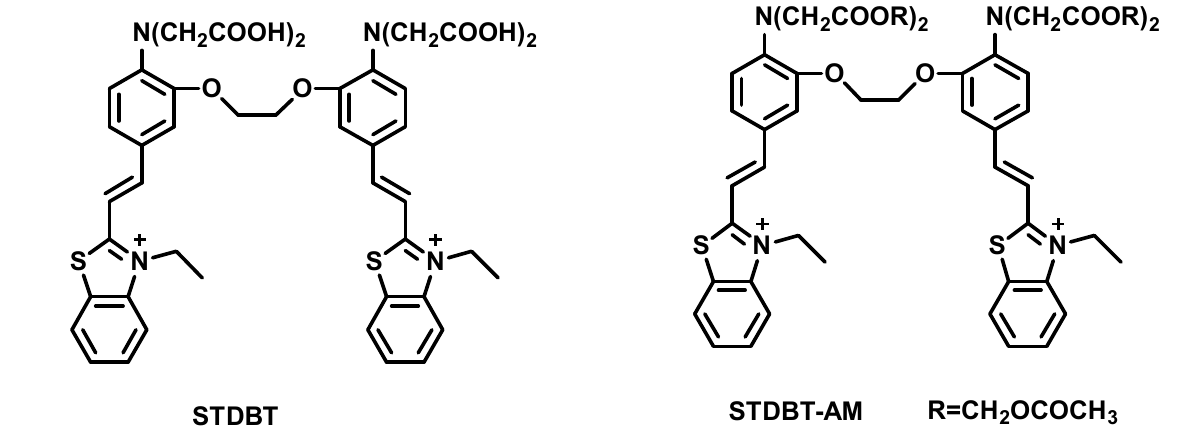
Figure 23. The chemical structures of STDBT and STDBT-AM. Table 2. Summary of the characteristic properties of nucleus-targeted fluorescent probes for intra- nuclear biomolecule detection.